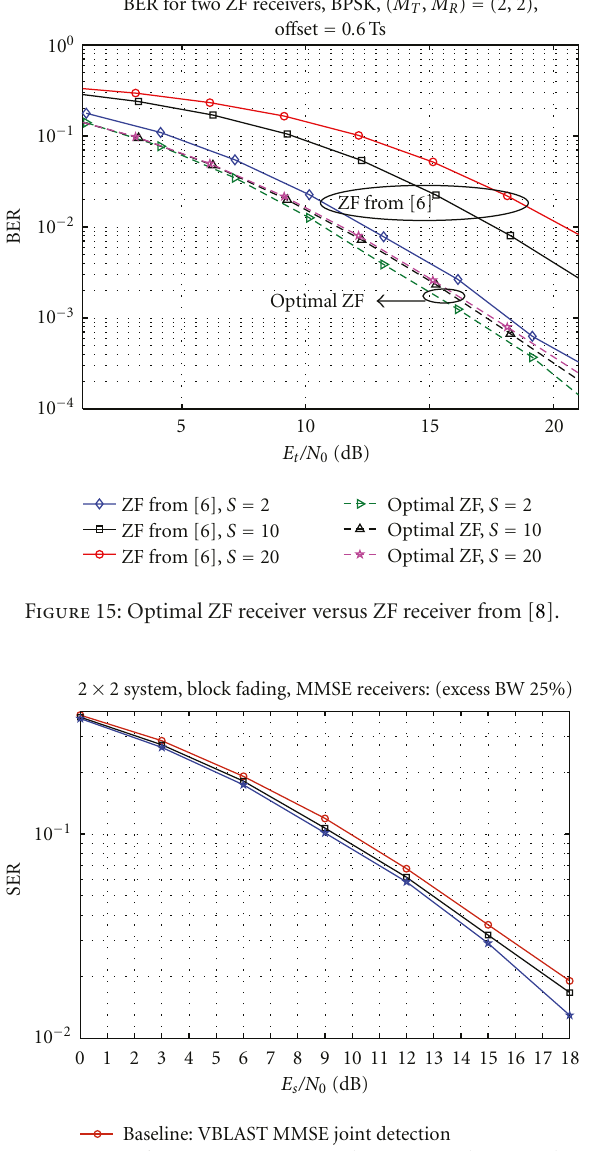
block sizes are equally e ffi cient. Very short block sizes lead to considerably less spectral e ffi ciency due to the inter gap idle time representing a higher